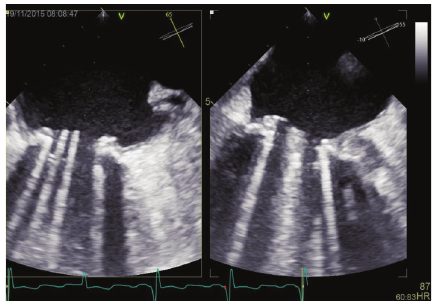
Figure 1: Transesophageal echocardiography of a mitral valve prosthesis. A thrombus originating from the valve ring is visible (arrow).